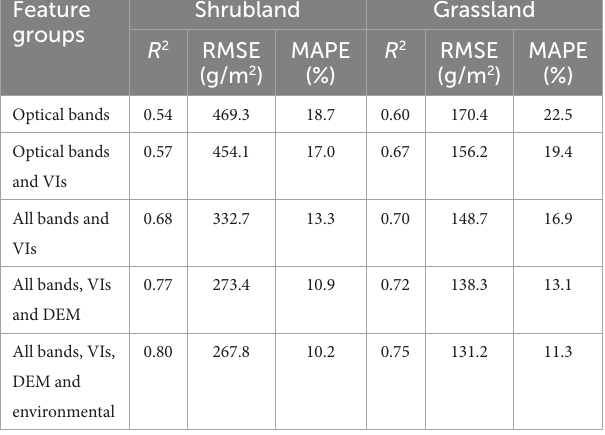
TABLE 3 Performance of various feature groups for AGB estimation using random forest. Feature